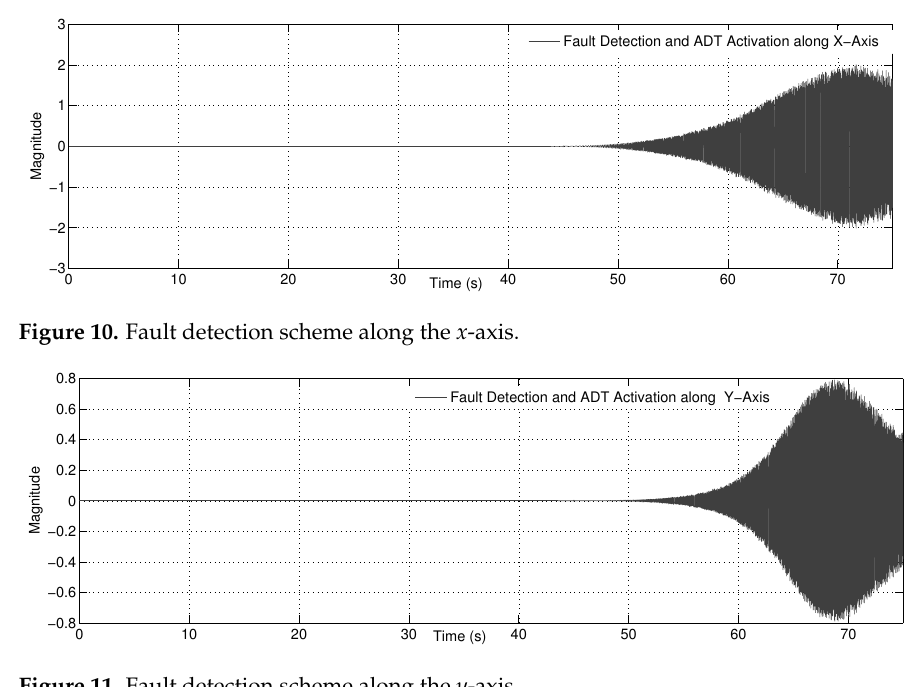
Figure 11. Fault detection scheme along the y